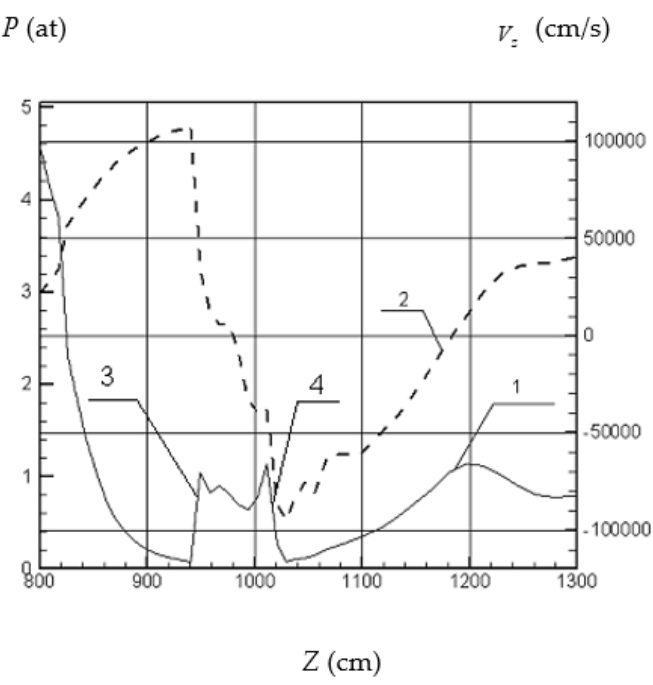
Figure 7. Distributions of pressure (1) and longitudinal velocity V z (2) along the solid propellant rocket motor axis (conical shape of the nozzle, h = 6 km, M=0.9). (3) Main shock wave, (4) secondary shock wave.